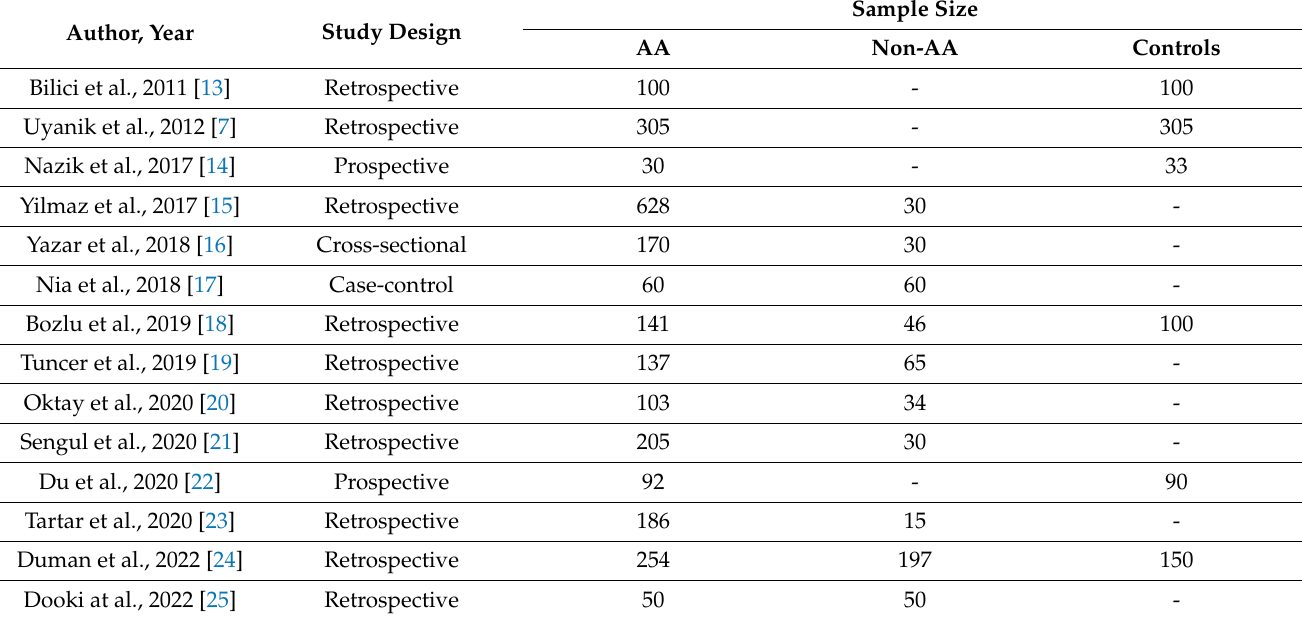
Table 1. Characteristics of the included